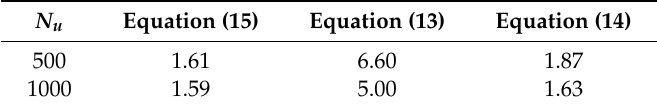
Table 2. Hourly peak factor values estimated with di ff erent